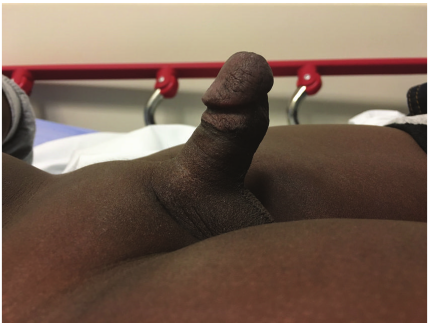
Figure 1: Physical examination during ED visit.